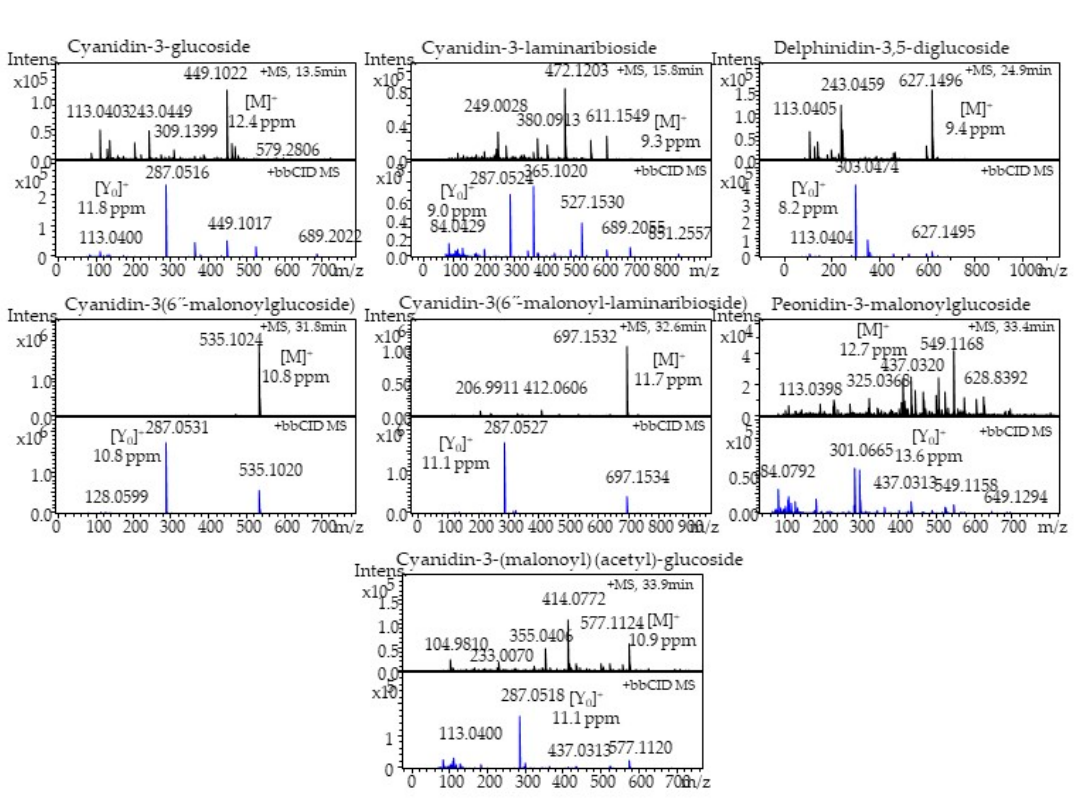
Figure 7. Seven major anthocyanins identified from red onion by LC-HR-ESI-QTOF-MS.